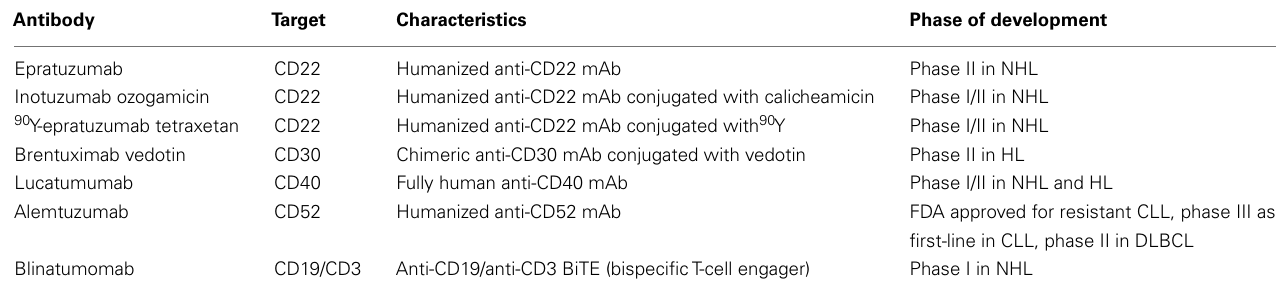
Table 2 | Clinical development of mAbs against antigens other than CD20.